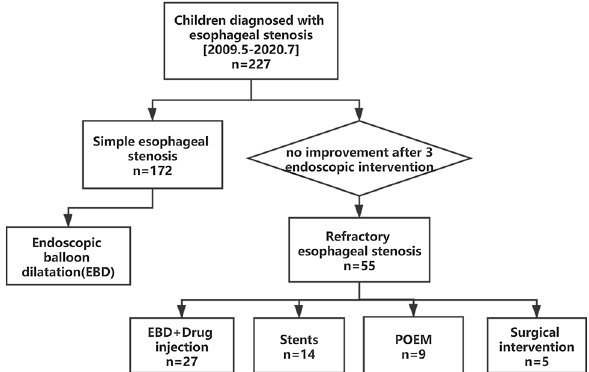
Figure 3. A flow diagram of children diagnosed with esophageal stenosis who required